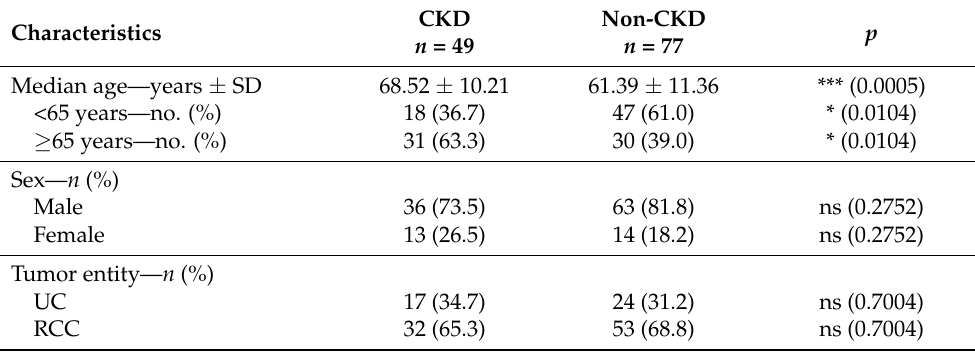
Table 1. Patients’ characteristics. CKD = chronic kidney disease; IMDC = International Metastatic Renal Cell Carcinoma Database; RCC = renal cell carcinoma; SD = standard deviation; UC = urothelial carcinoma; ns = not significant; * = significant; *** = extremely significant.